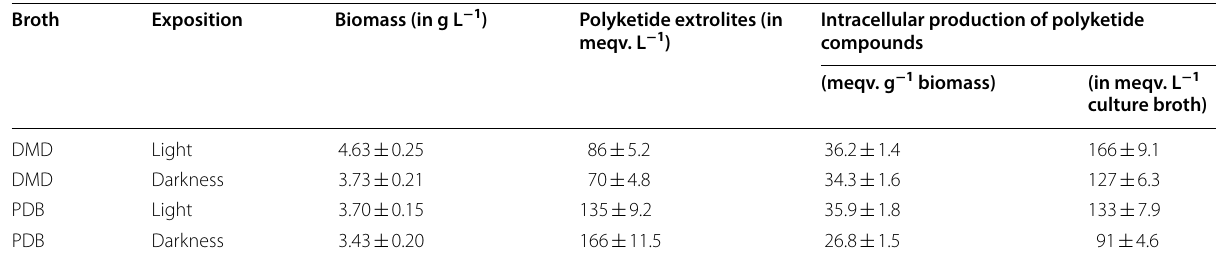
Table 1 Volumetric production of biomass (in g L − 1 ), polyketide extrolites (in meqv L − 1 ) and intracellular production of polyketide compounds (in meqv g − 1 of dry biomass, or in meqv L − 1 of culture broth) from the Fusarium oxysporum LCP531 strain grown in PDB and DMD medium for 7 days, under light exposure or darkness Broth Exposition Biomass (in g L − 1 ) Polyketide extrolites (in meqv. L − 1